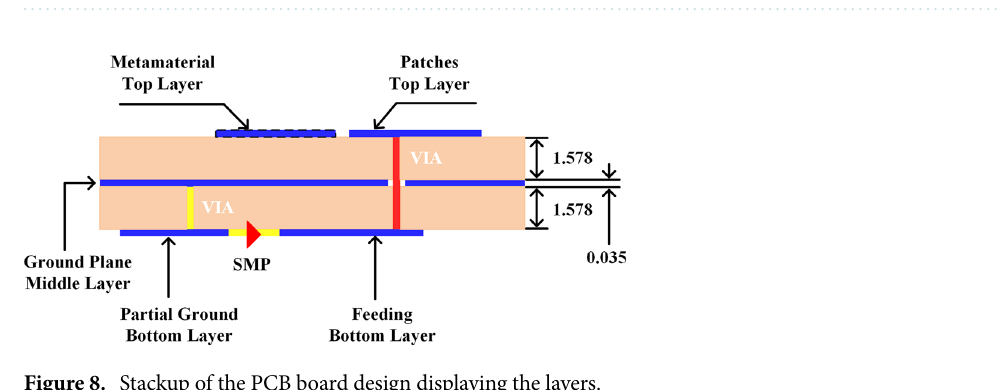
Figure 7. MTM, simulated results at x-axis of 1 × 1 unit cell: ( a ) permittivity, ( b ) permeability, ( c ) refractive index, ( d ) impedance.